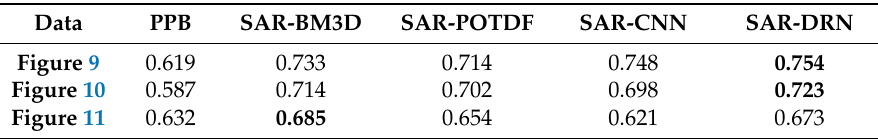
Table 6. EPD-ROA indexes for the real despeckling